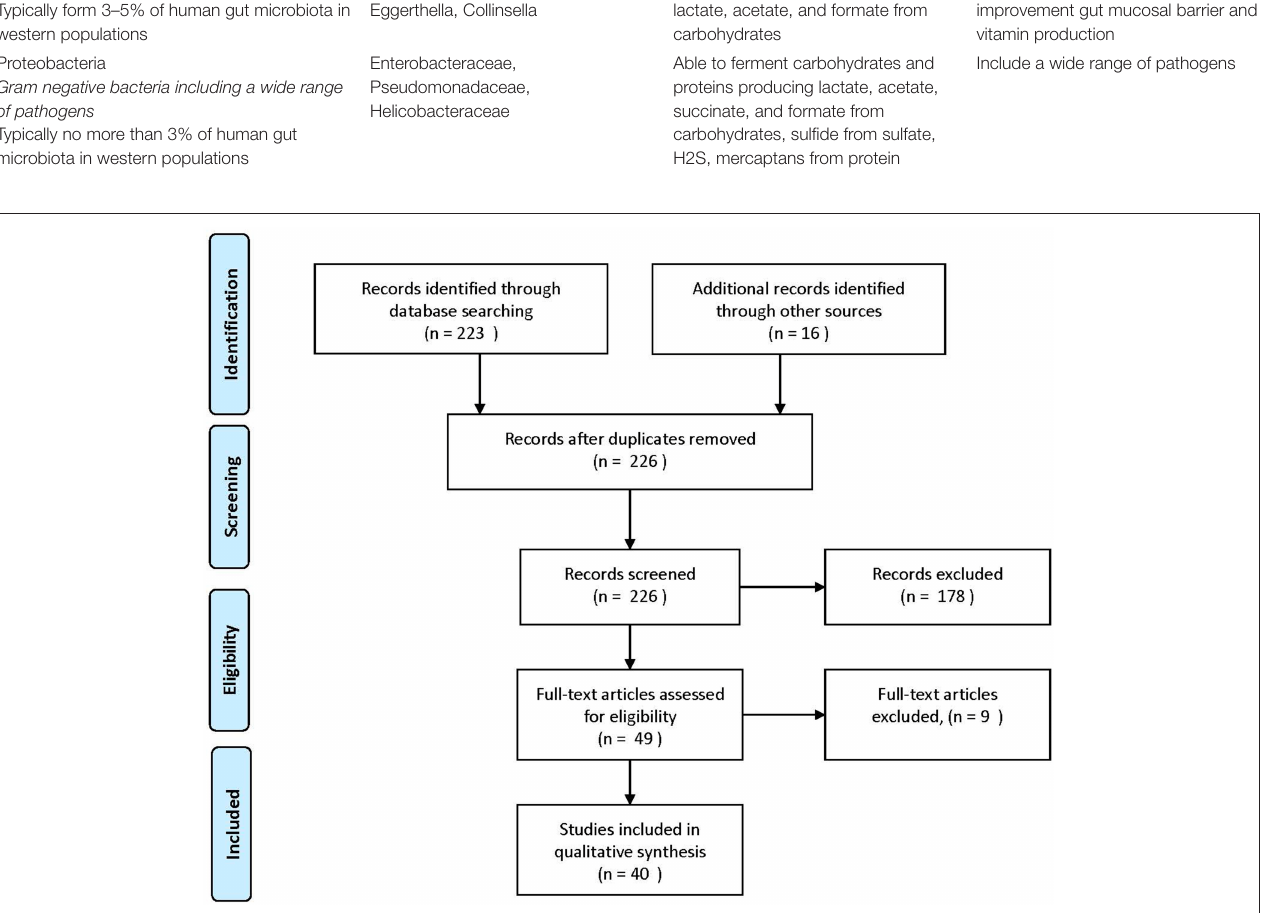
FIGURE 1 | Process of selecting included human studies. Adapted from Moher et al.